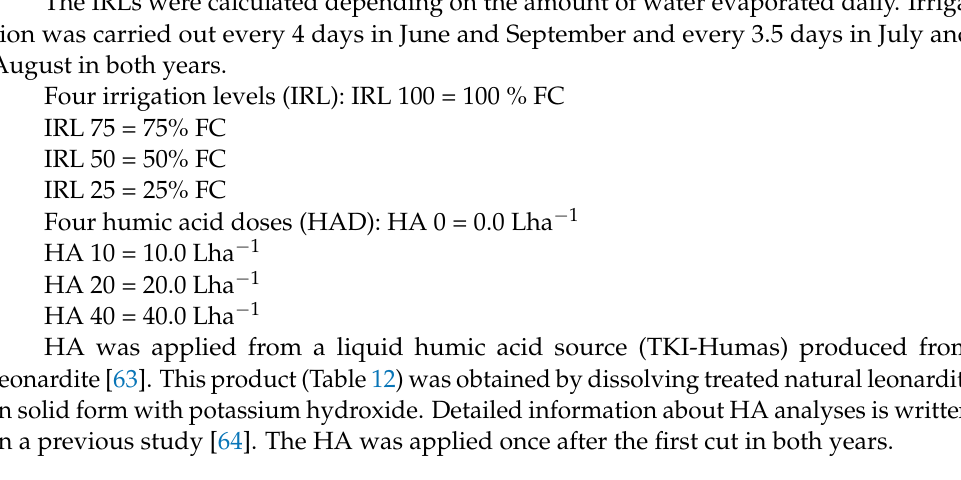
Table 12. Some properties of HA used in the